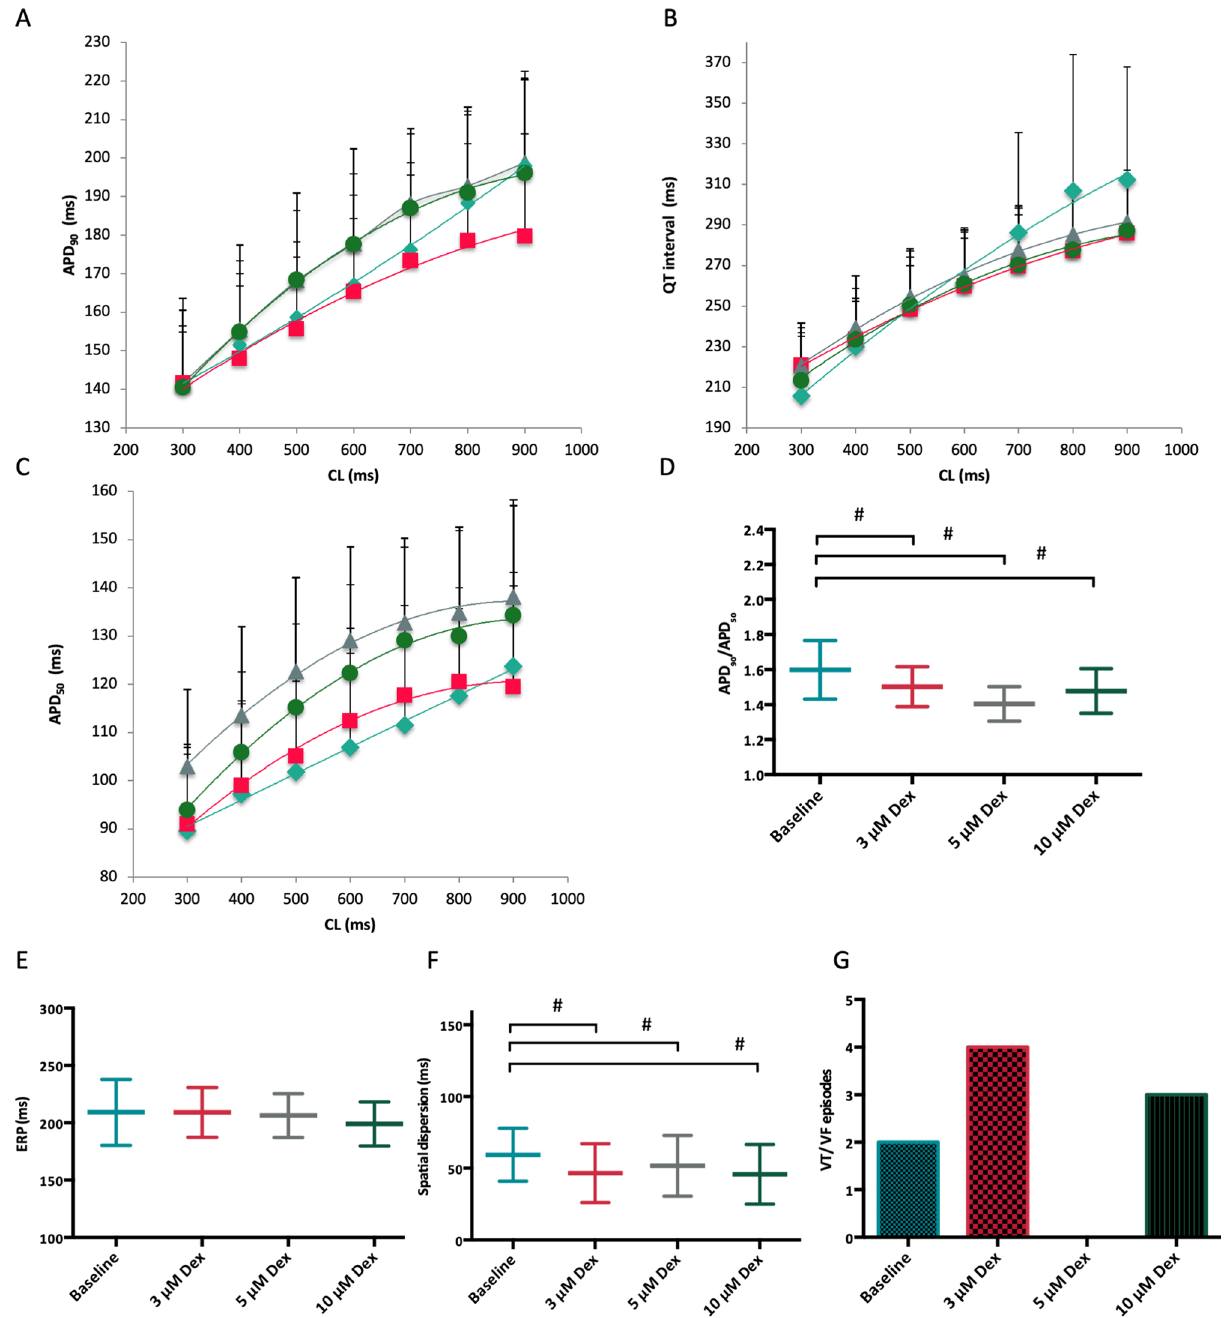
Figure 3. ( A , B , C ) Cycle-length dependent action potential durations at 90% of repolarization (APD 90 ), QT interval and action potentials at 50% of repolarization (APD 50 ) under baseline conditions (◆) and after treatment with 3 µM ( ■ ), 5 µM ( ▲ ) or 10 µM ( ● ) dexmedetomidine (Dex). ( D ) Ratio of action potential duration at 90% and 50% of repolarization (APD 90 /APD 50 ). ( E ) Concentration-dependent effect of dexmedetomidine on spatial effective refractory periods (ERP). ( F ) Impact of dexmedetomidine on spatial dispersion of repolarization. ( G ) Number of ventricular tachycardia (VT)/ fibrillation (VF) induced by programmed ventricular stimulation (# = p < 0.05 compared to baseline The distribution of different cell types with different ion channel distribution either within the ventricular wall or between different areas of the ventricles can create a voltage gradient which is reflected by the spatial dispersion of repolarization 18 . For instance, subepicardial M cells possess a larger late sodium current but a reduced potassium current I Ks , leading to a longer action potential as compared to epicardial or endocardial cells 20,21 . This results in a transmural dispersion of repolarization which can be reduced by different calcium 22 or sodium channel inhibitors 23,24 . The reduction of spatial dispersion of repolarization may be explained by different